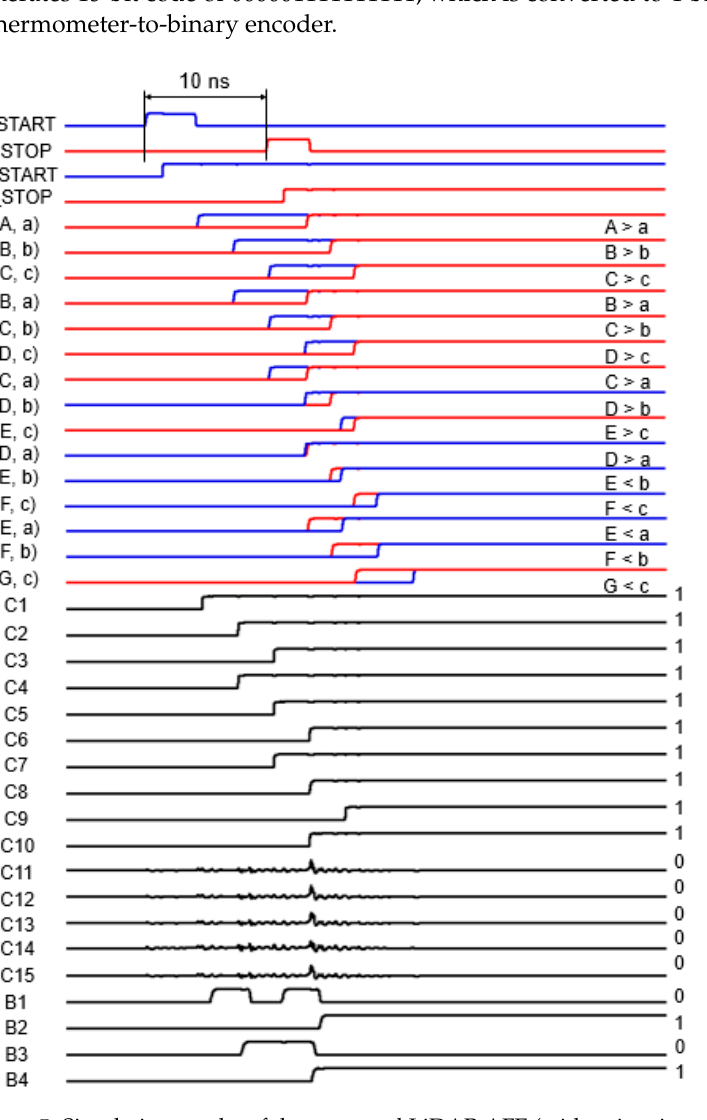
Figure 5. Simulation results of the proposed LiDAR AFE (with a time interval of 10 ns).